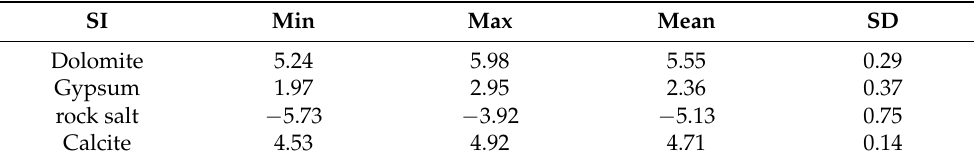
Table 2. Mineral saturation index in Sr-rich